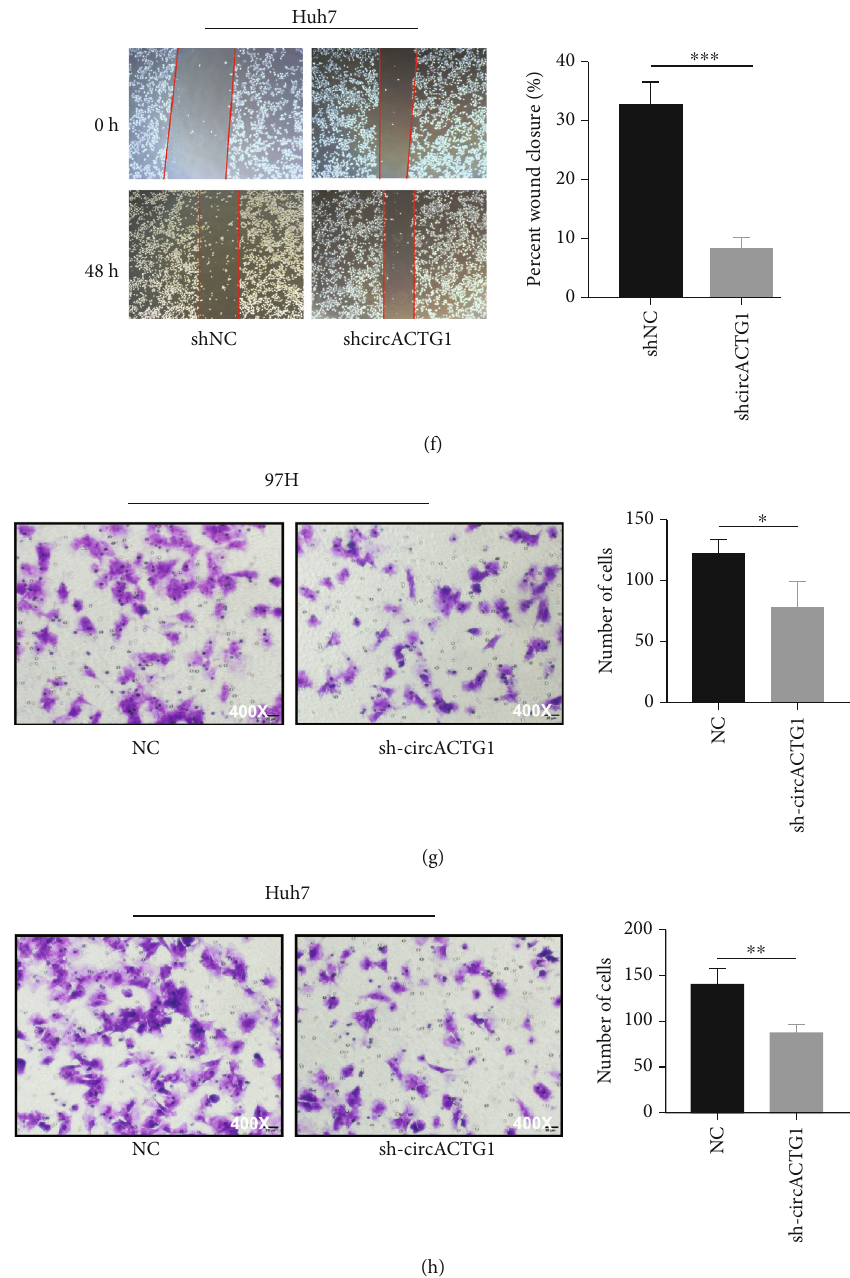
Figure 2: Knockdown of circACTG1 inhibited 97H and Huh7 cells proliferation, migration, and invasion. (a and b) Knockdown of circACTG1. (c – h) Abilities of proliferation (c and d), migration (e and f), and invasion (g and h) in 97H and Huh7 cells with circACTG1 knockdown were tested by CCK8 assay, wound healing assay, and transwell assay,